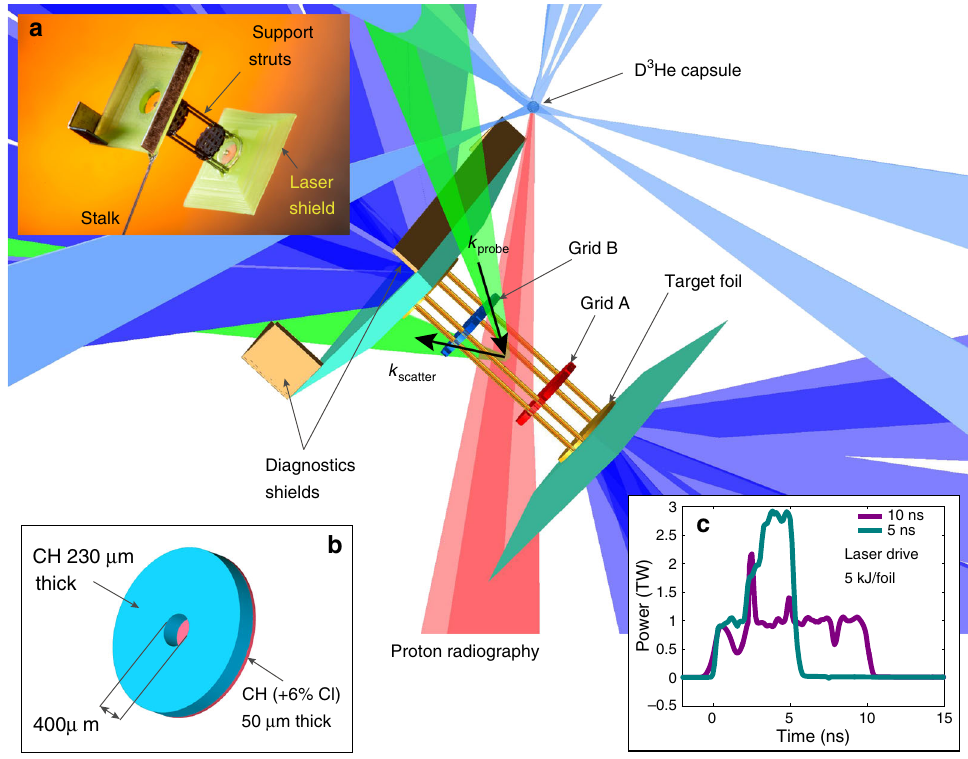
Fig. 1 Experimental con fi guration. The main target (see photo in a ) consists of two CH foils doped with 6% chlorine in atomic number ( b ) that are separated by 8 mm. Each foil is illuminated by ten 500 J, 1 ns pulse length, frequency tripled (351 nm wavelength) laser beams with 800 μ m spot diameter. The beams are stacked in time to achieve the two pulse pro fi les shown in c . An additional set of 17 beams, all fi red simultaneously, are used to implode a 420 μ m diameter capsule consisting of a 2- μ m-thick SiO 2 shell fi lled with D 2 gas at 6 atm and 3 He at 12 atm. The implosion produces mono-energetic protons at 3.3 and 15 MeV with ~40 μ m diameter source size, which traverse the plasma and are then collected by a CR-39 nuclear track detector with a total magni fi cation factor of 28. The plasma expansion towards the center of the target is perturbed by the presence of two grids, placed 4 mm apart, with a 300 μ m hole width and 300 μ m hole spacing. Grid A has the central hole aligned on the center axis connecting the two foils, while grid B has the hole pattern shifted so that the central axis crosses the middle point between two holes. Thomson scattering uses a 30 J, 1 ns, frequency doubled (wavelength λ = 526.5 nm) laser beam to probe the plasma on the axis of the fl ow, 400 μ m from the center and in a 50 μ m focal spot, towards grid B. The scattered light is collected with 63° scattering angle and the geometry is such that the scattering wavenumber k = k scatter − k probe , where k scatter j j (cid:2) k probe